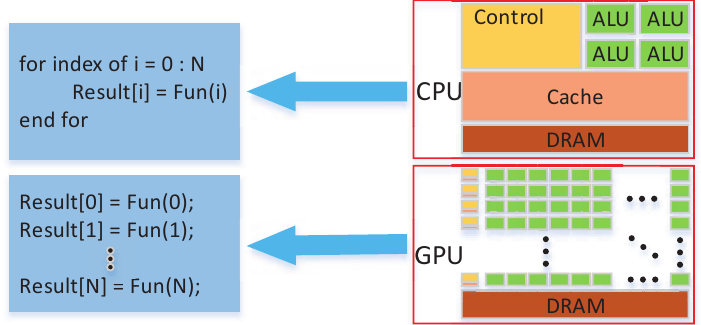
Figure 7. Loop unfolding optimization strategy.